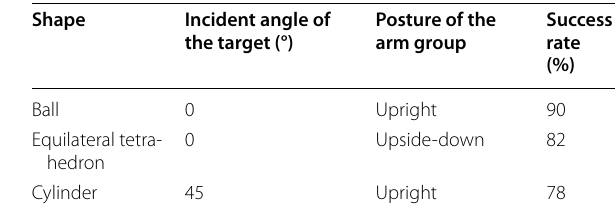
Table 3 Parameters of three